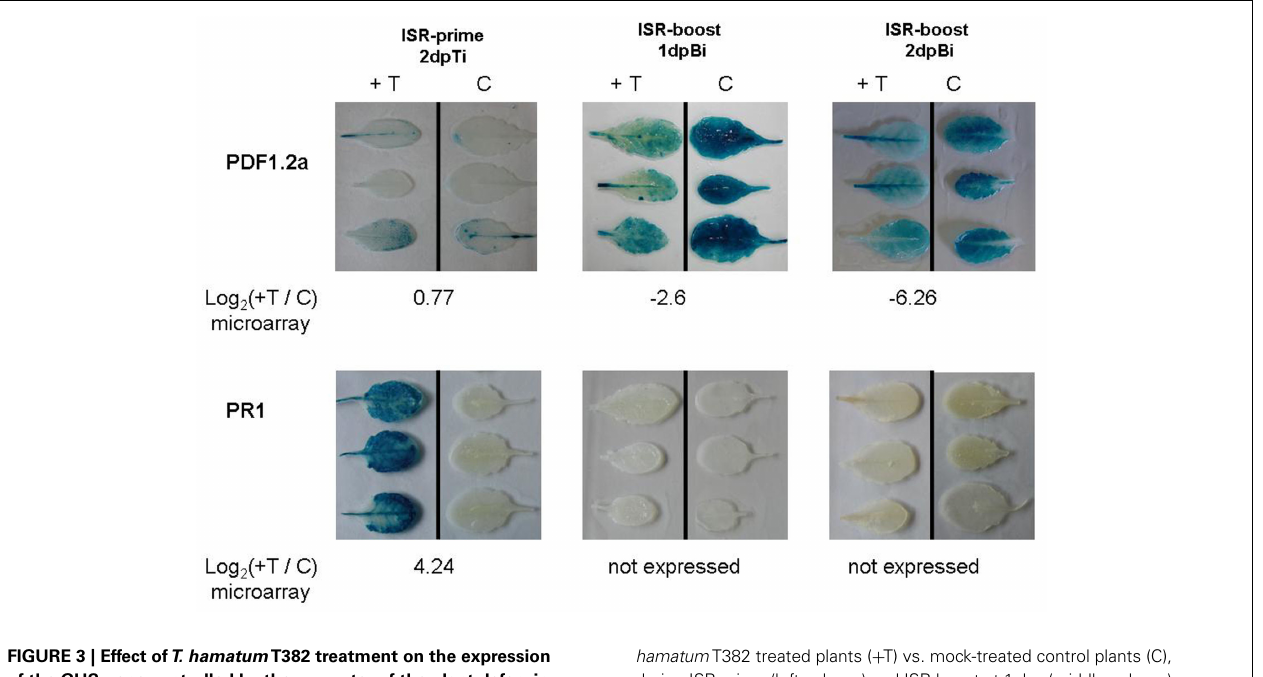
FIGURE 3 | Effect of T. hamatum T382 treatment on the expression of the GUS-gene controlled by the promoter of the plant defensin PDF1.2a and the pathogenesis-related protein PR1. GUS-staining was done on leaves of transgenic lines expressing the different promoter-GUS fusions. For each of these genes results are shown for T.